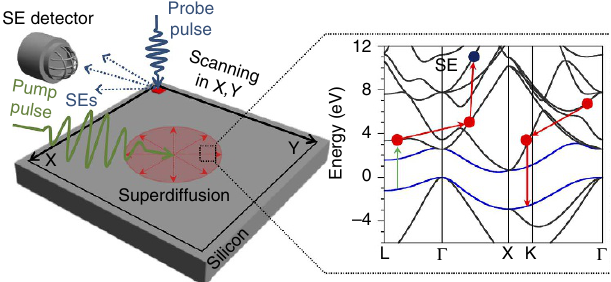
Figure 1 | Schematic of scanning ultrafast electron microscopy (SUEM) imaging. In our SUEM measurements, the optical pump pulse excites electron-hole pairs in silicon, which undergo super-diffusion until they equilibrate with the environment. Electron probe pulses with a known delay raster-scan the surface, resulting in the emission of secondary electrons (SEs) employed to image the carrier dynamics. The right panel schematically shows carrier dynamical processes mapped onto the bandstructure of Si. Shown are the carrier optical excitation (green arrow), as well as energy gain and recombination (upward and downward oriented red arrows, respectively) due to carrier scattering processes. The SEs preferentially observed by SUEM (blue dot) are emitted from the high-energy tail of the carrier